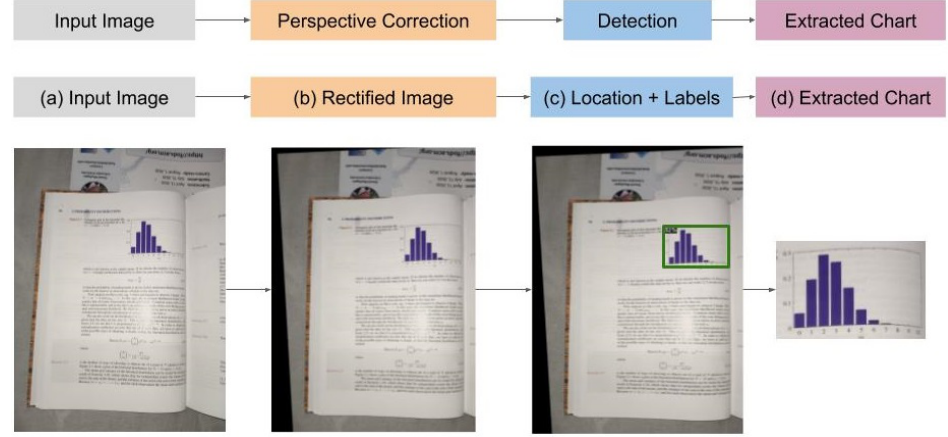
Figure 7. Illustrative example: ( a ) tilted input image, following the ( b ) perspective correction, ( c ) that eased the chart detection ( d ) resulting in a clean-cut bar